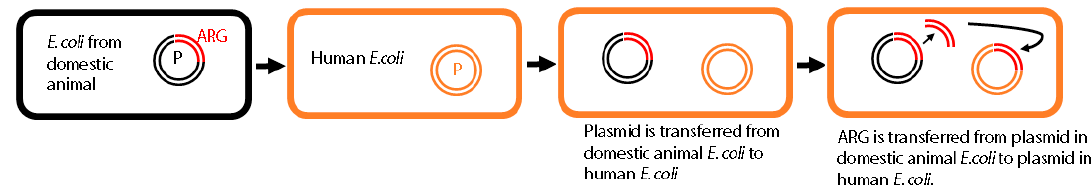
Figure 1. Example of antimicrobial resistance gene (ARG) movement that affects the complexity of studying antimicrobial resistance transmission. Plasmids (P) carried by E. coli from a food-animal can be transferred to human E. coli and the ARG can move between plasmids.